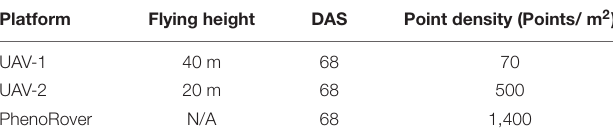
TABLE 4 | Point density of sample data on